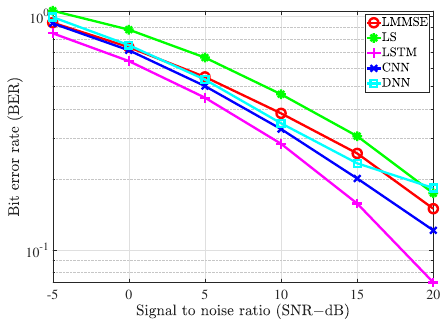
Figure 13. The BER of the channel estimate vs. the SNR level with f D = 36 Hz.